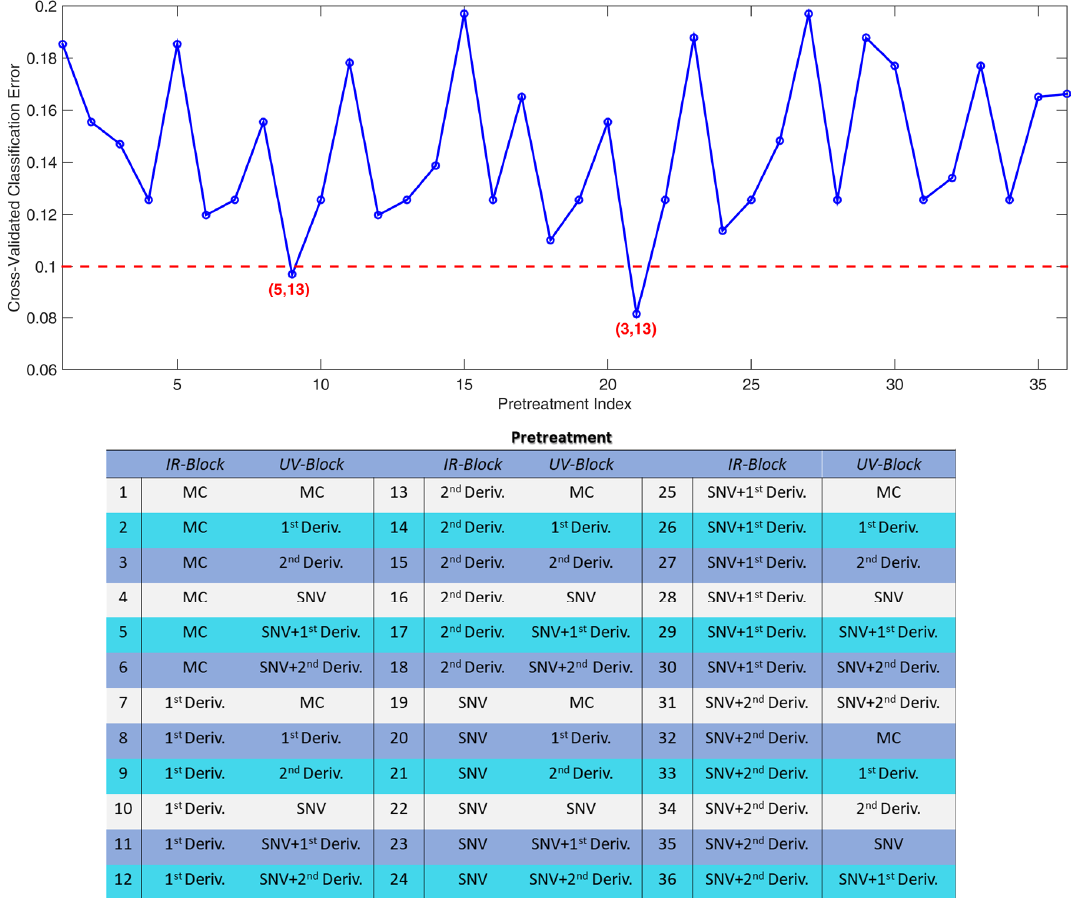
Figure A1. SO-PLS-LDA. Cross-validated classification errors. Numbers in brackets represent the number of LV extracted by the IR and the UV-Vis blocks, respectively. The dashed line is not a cut-o ff value, it is meant to help the appreciation of the local minima. In the table, “MC” stands for “mean centering” and “Deriv.” for “derivative”.